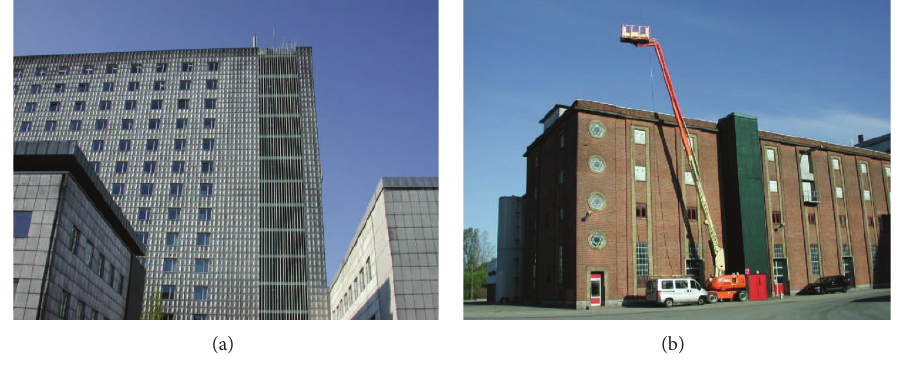
Figure 1: Positions of base stations (a) BS2, (b) BS1.